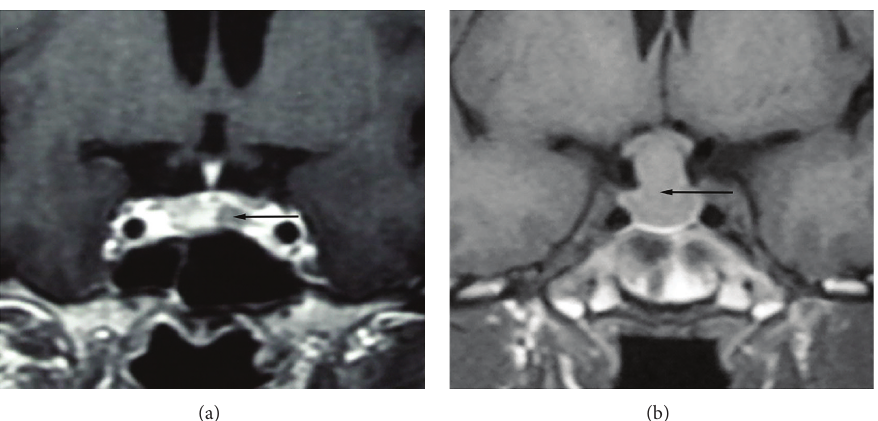
Figure 1: Representative T1-weighted coronal MRI scans. (a) Microadenoma (arrow). (b) Macroadenoma expanding into the suprasellar cistern